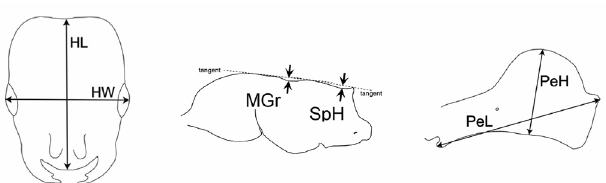
Fig 1. Six measured parts (HL, HW, MGr, SpH, PeL, PeH) of Cardiocondyla sl. kagutsuchi workers for morphological analysis. These figures were drawn from the SEM photographs of the specimens. The left figure represents a dorsal view of the head, the middle shows a lateral view of the mesosoma and that on the right is a lateral view of the petiole. HL, HW, MGr, SpH, PeL and PeH represent the head length, head width, depth of the metanotal groove, height of the propodeal spine, petiole length and petiole height,